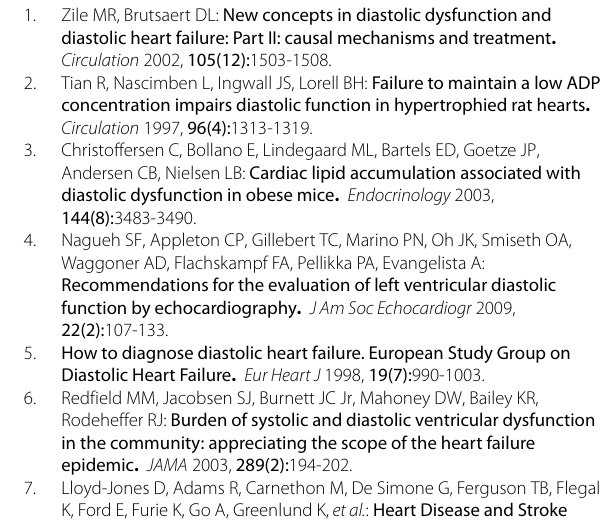
Additional file 1 Supplementary Tables and Figures . Table S1. Eleven LVDD-related echocardiographic parameters in the ICA analysis. Table S2. Absolute echocardiographic parameter loadings of 2-, 3-, 6-component ICA. Table S3. Spearman's correlation coefficients between traditional car- diovascular risk factors and the latent LVDF trait. Table S4. Descriptive statis- tics for primary echocardiographic endophenotypes (2 components set). Table S5. Descriptive statistics for primary echocardiographic endopheno- types (3 components set). Table S6. Descriptive statistics for primary echocardiographic endophenotypes (6 components set). Table S7A-C. Characteristics of 39 SNPs in the PPARGC1A , PPARA , and PPARG genes. Figure S1. Plots of echocardiographic endophenotype loadings of E21 and E22. Figure S2. Plots of echocardiographic endophenotype loadings of E31, E32 and E33. Figure S3. Plots of echocardiographic endophenotype loadings of E61-E66. Figure S4. Haploview LD display of 34 PPARGC1A SNPs. Figure S5. Haploview LD display of 15 PPARA SNPs. Figure S6. Haploview LD display of the 14 PPARG SNPs. Figure S7. Comparison of the distributions of P values between latent LVDD trait (E61) and primary 14 echocardiographic endo-